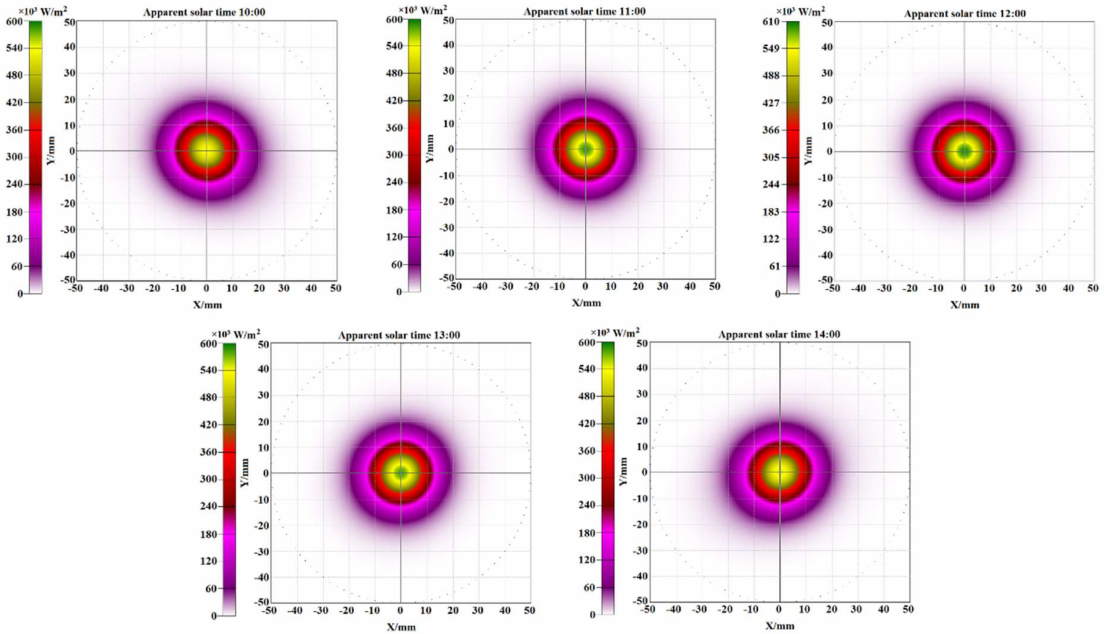
Figure 8. The flux density distributions of the focal spots for various apparent solar